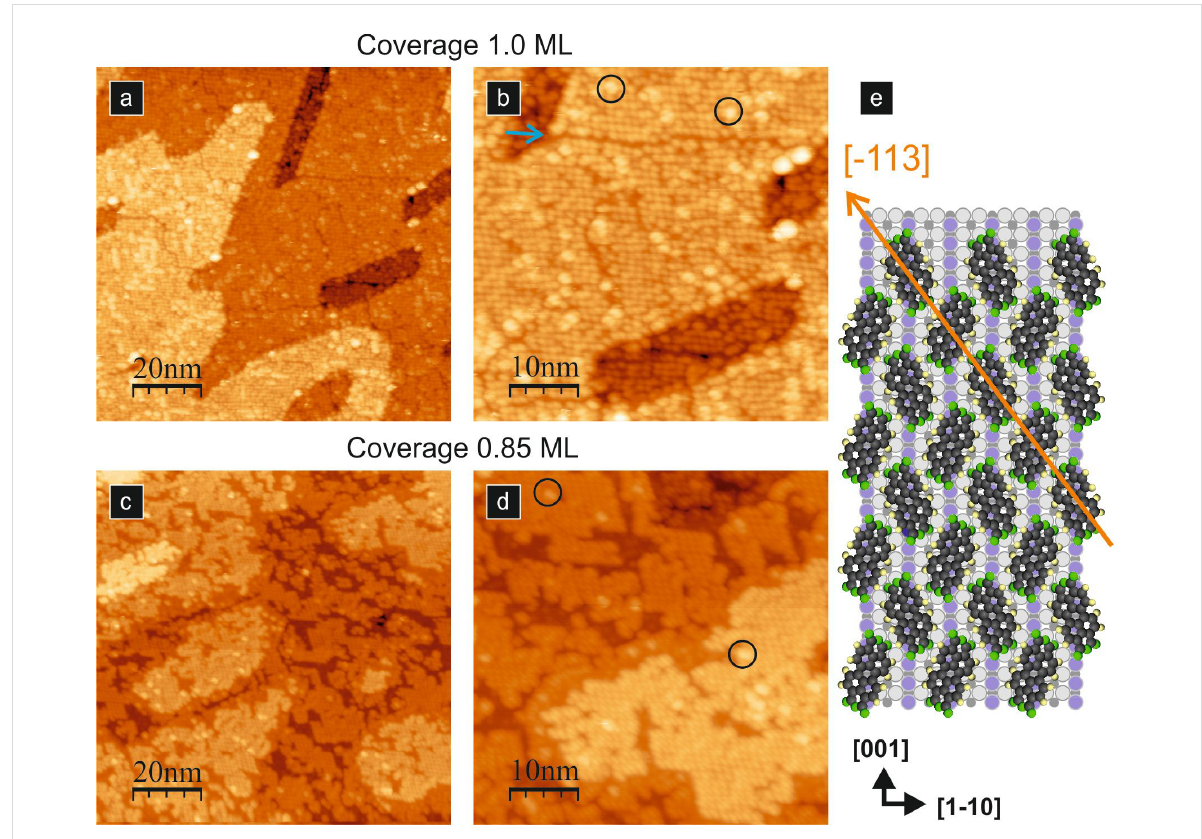
Figure 4: A well-ordered PTCDA layer formed at room temperature. (a) and (b): empty-state STM images of a closed layer, where the blue arrow indi- cates the domain boundary and black circles indicate molecules trapped on top of the first layer; (c) and (d): empty-state STM image of 0.85 ML coverage of PTCDA molecules, where black circles indicate molecules trapped on top of the first layer. All STM images acquired with 2.0 V bias voltage and 2 pA tunnelling current. (e) A structural model of an approx. 1.0 ML well-ordered PTCDA layer.